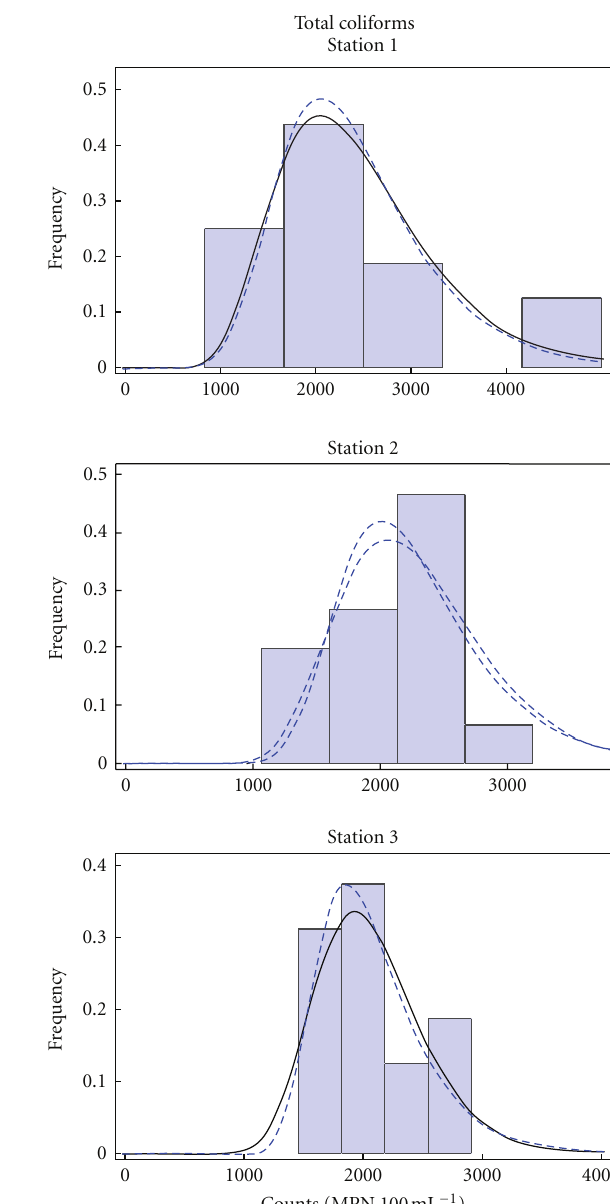
Figure 5: Examples of the autocorrelation functions (ACF) of coliforms, M. aeruginosa, and microcystin records of the water sampled at Station 2. Figure 6: Histograms of total coliforms counts in the water at the three sampling sites described by the log-normal (solid line) and extreme value (dashed line) distribution